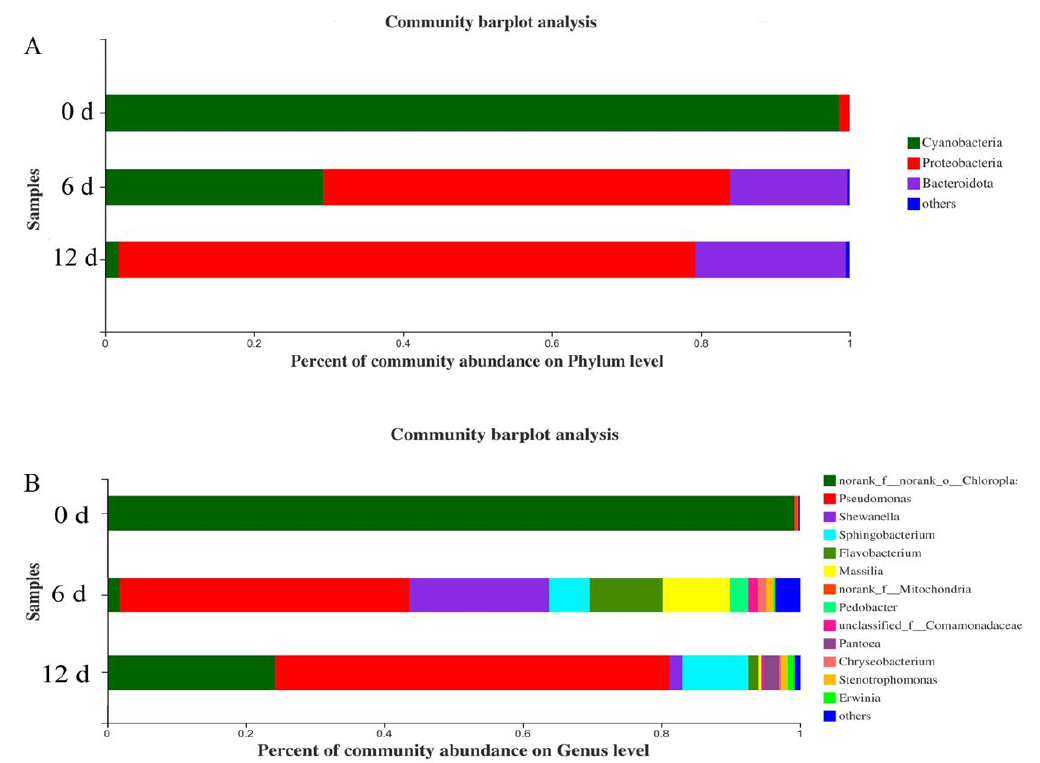
Figure 10. Changes in percent of community abundance on phylum ( A ) and genus ( B ) levels.